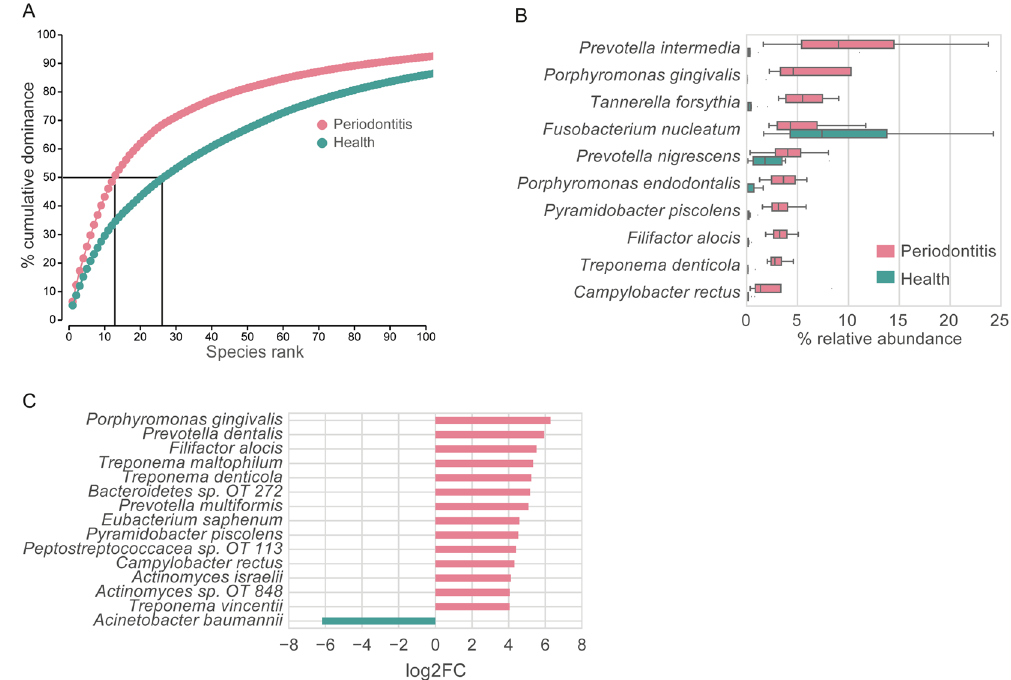
Figure 2. Taxonomic composition of transcripts in health and disease based on HOMD database. ( A ) Dominance plot showing the cumulative average contribution of individual genomes ranked according to transcript abundance of the total mapped reads. ( B ) The relative abundance of transcripts from the top 10 most abundant species in periodontitis in comparison with their abundance in health. ( C ) The differential activity of the microbial species based on the total mapped transcripts. The differential expression analysis was carried out by edgeR. Only species with FDR ≤ 0.05 and log2CPM ≥ 8 and absolute log2FC ≥ 4 are shown. If there were several strains for one species, those transcripts were pooled. Transcripts were mapped to the HOMD database. The bottom and top of the box show the first and third quartiles, the line inside the box indicates the